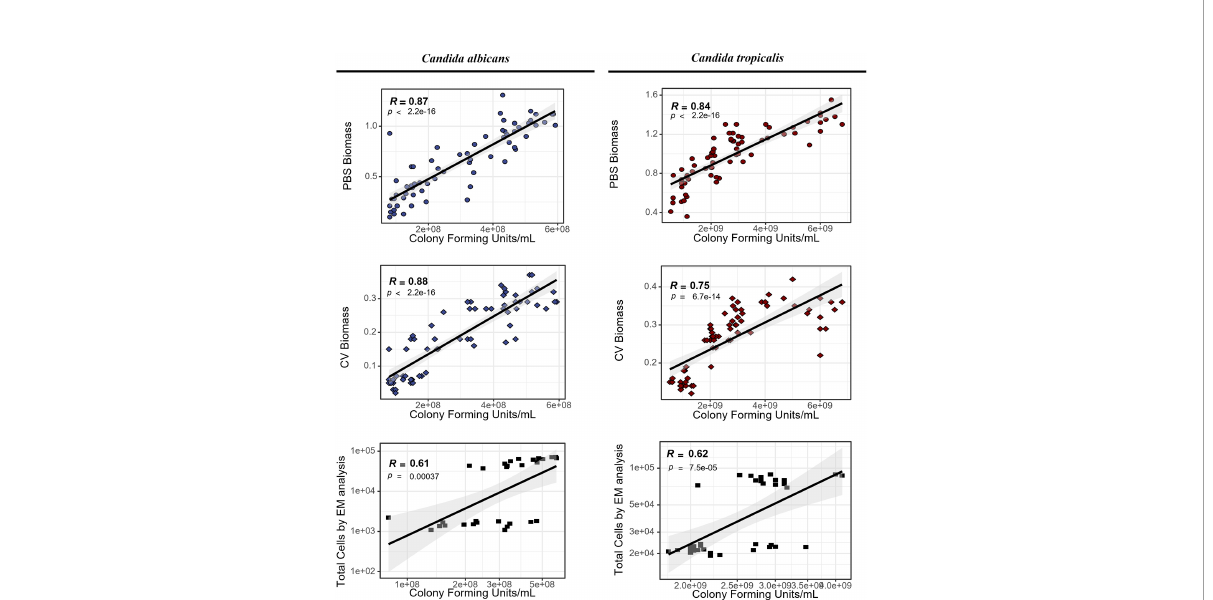
FIGURE 4 Comparative analysis of bio fi lm development through crystal violet (CV) staining and phosphate-buffered saline (PBS) suspension for biomass quanti fi cation by optical density assays, total cell count by epi fl uorescence microscopy (EM) analysis, and colony-forming unit (CFU) counting assays. Least-squares linear regression models were used to compare the four methods to assess bio fi lm development using R studio version 4.0 (RStudio Team,